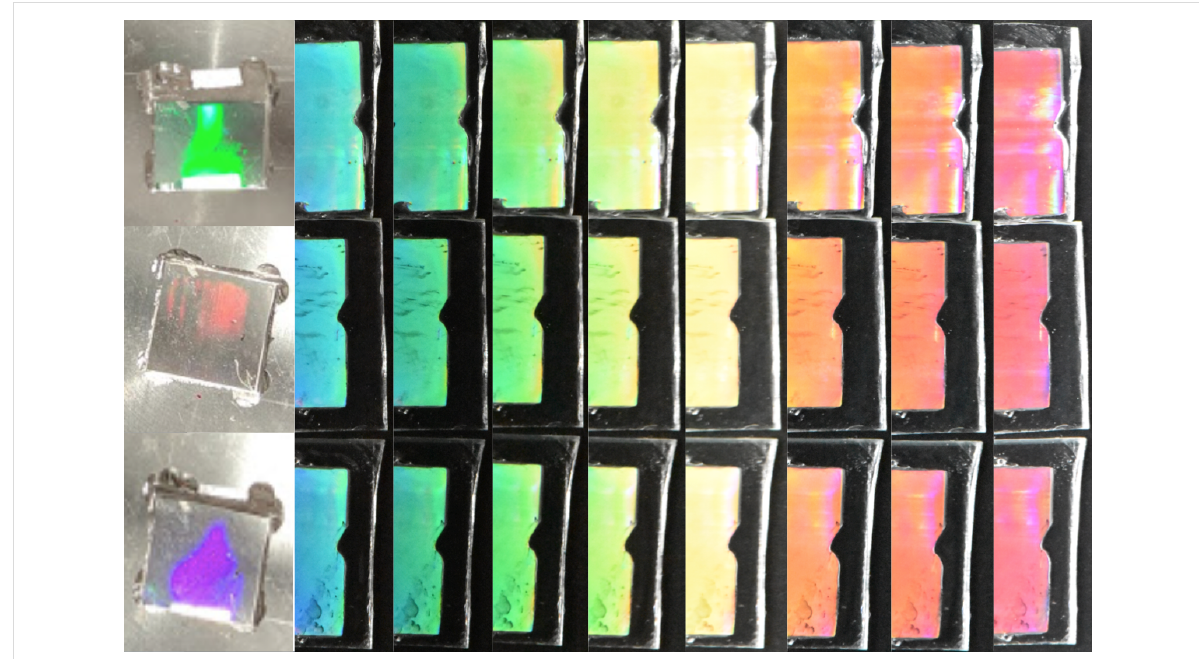
angle and the opposite back angle, β , are considered essential to estimate the quality of the copy. To evaluate the quality, the angles obtained from the copies are directly compared to the angles taken from the measurements of the master. Only the linear parts are considered in the calculation, as shown in Figure 2. Analogously to the pitch case, the mean master angle is considered the maximum achievable value. The lowest value is 0°.